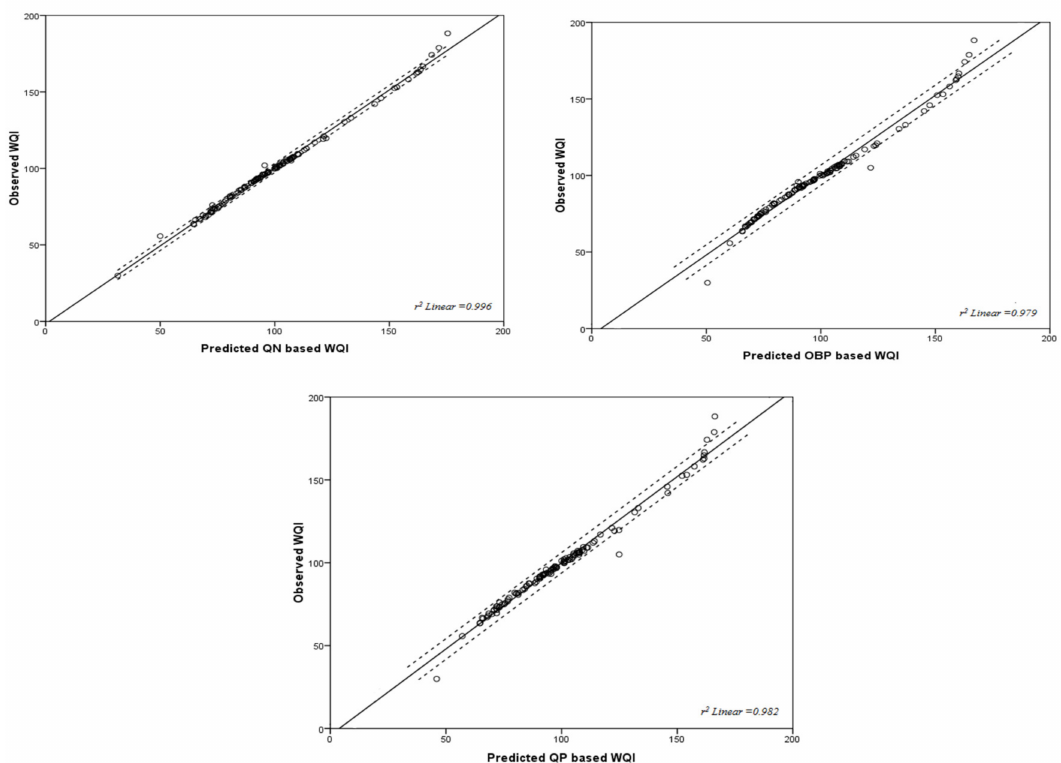
Figure 3. Predicted versus observed WQI for the ANN training algorithms-based MLR models.